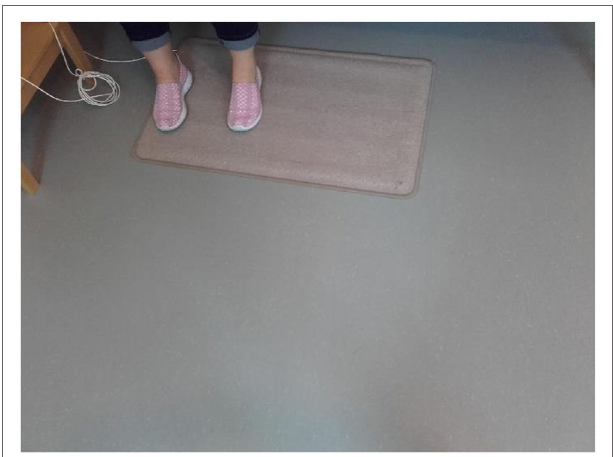
FigUre 3 | Doormat with integrated